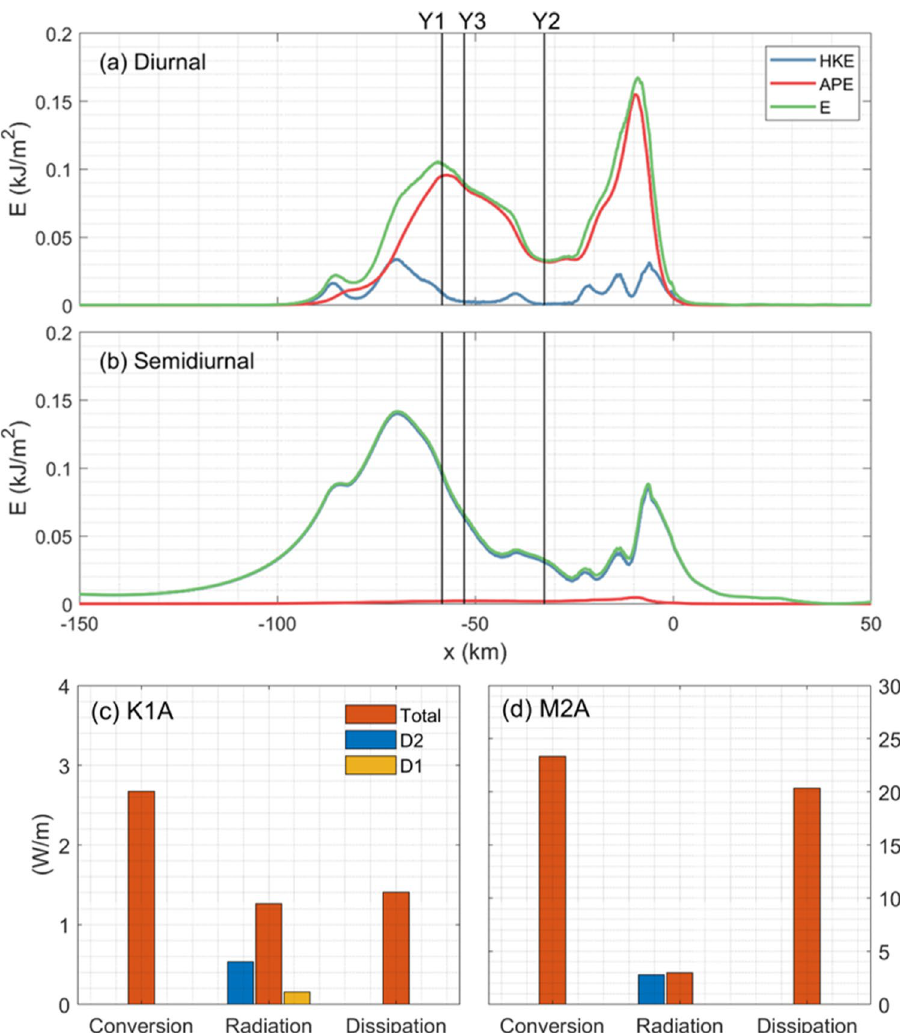
Figure 10. Depth-integrated ( a ) diurnal and ( b ) semidiurnal HKE, APE and E for runs K1A and M2A, respectively. Domain-integrated barotropic-to-baroclinic energy conversion, baroclinic energy radiation and dissipation for runs ( c ) K1A and ( d ) M2A. Red and green bars in ( c ) and ( d ) indicate filtered semidiurnal and diurnal energy radiation,